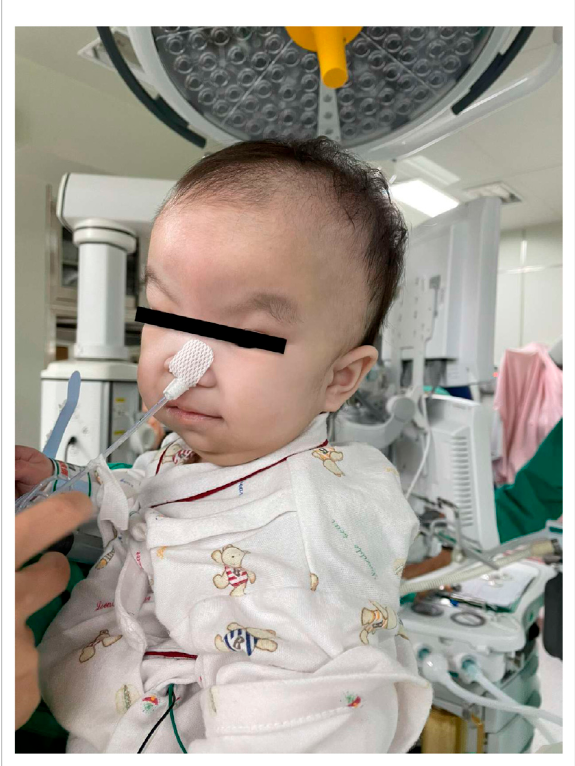
FIGURE 1 Photo of the patient before the port-a-cath exchange. Her dysmorphic features were wide prominent forehead, fl at nose, large anterior fontanelle, web neck, and skeletal